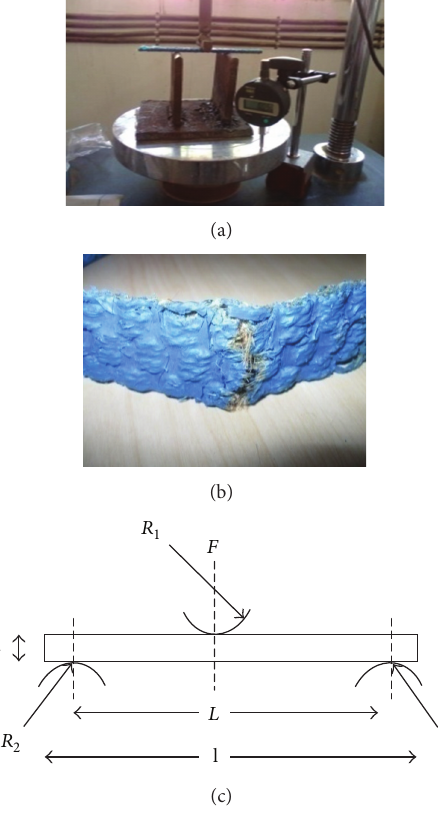
Figure 3: (a) Flexural testing (b) Flexural fracture of woven sisal FRP composite; (c) dimensions of the sample for flexural